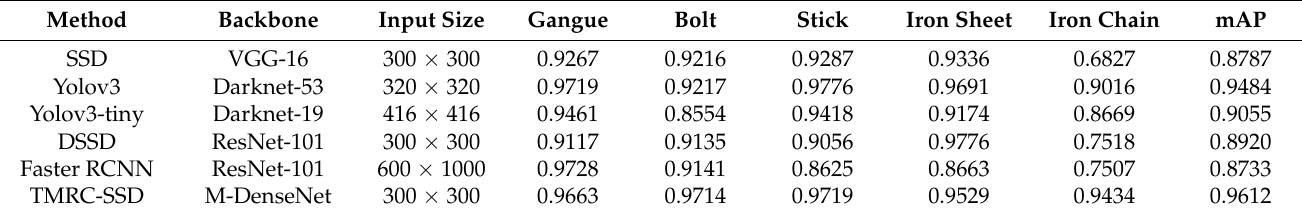
Table 4. Performance with different methods for five type of